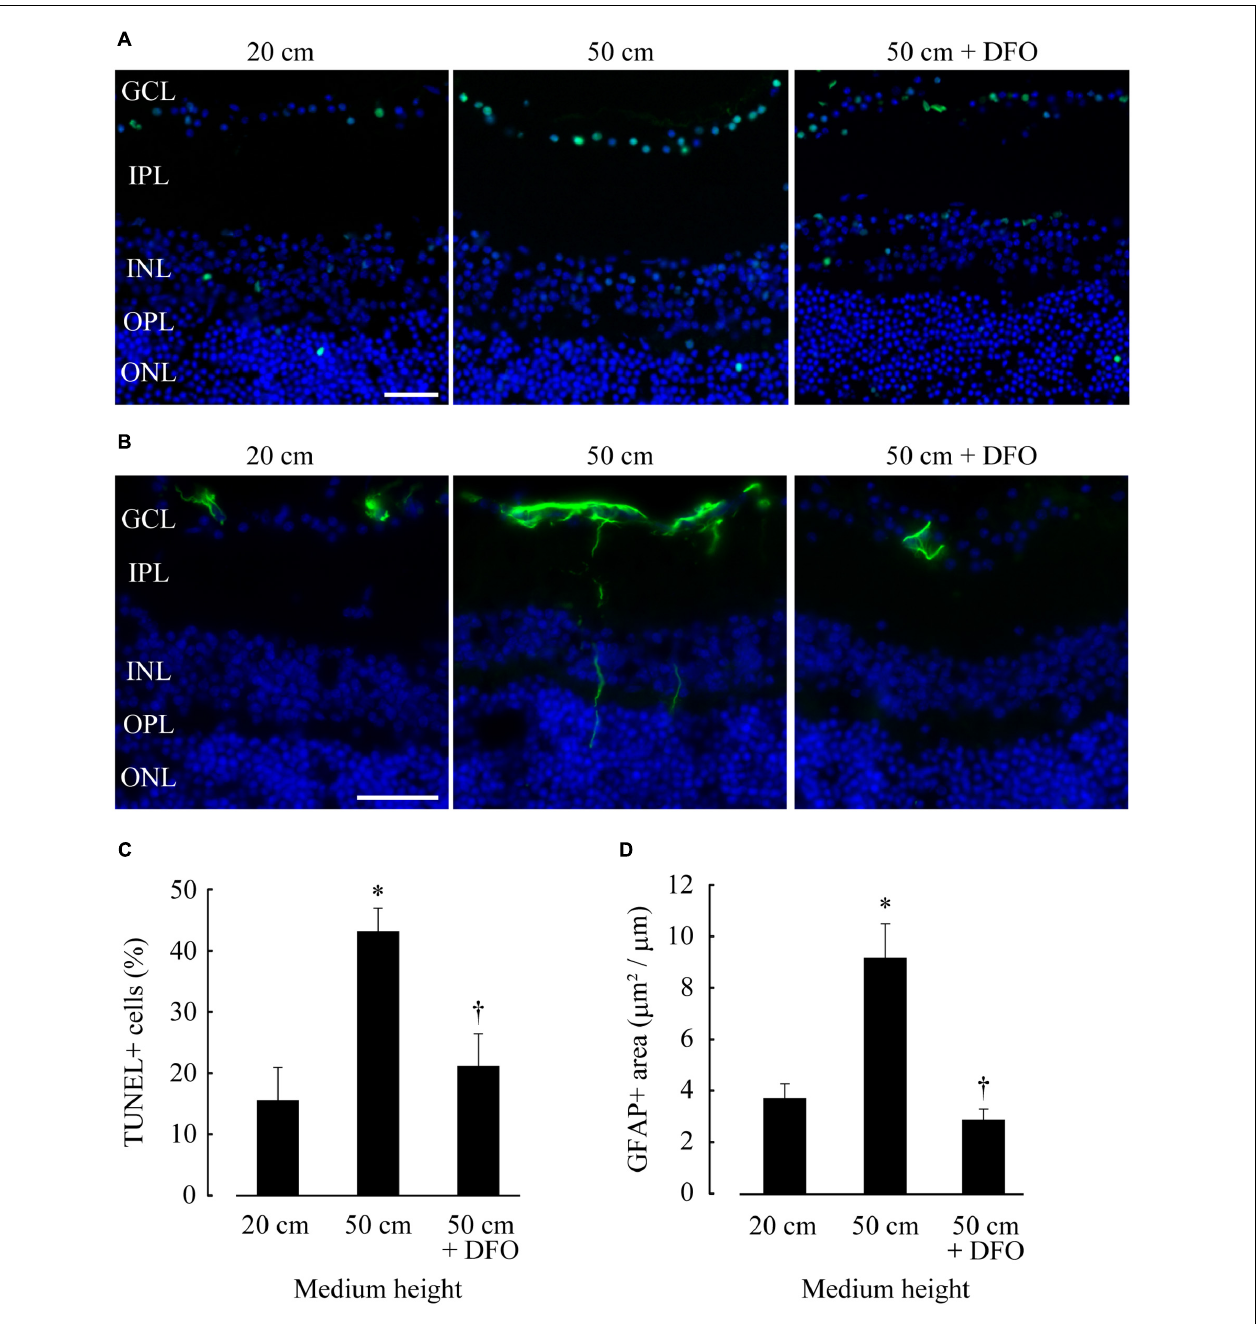
FIGURE 3 | Retinal ganglion cell (RGC) apoptosis and glial activation increased at 50 cm H 2 O pressure and decreased following deferoxamine (DFO) treatment. (A,B) In situ TUNEL (A, green) and GFAP immunohistochemistry [ (B) , green] assays were performed on frozen sections of retinae, and the sections were counterstained with DAPI [ (A,B) , blue]. Bar = 40 µ m. GCL, ganglion cell layer; IPL, inner plexiform layer; INL, inner nuclear layer; OPL, outer plexiform layer; ONL, outer nuclear layer. (C,D) The average percentage of TUNEL-positive nuclei in GCL (positive cell number/total cell number) and the average GFAP-positive area in retinae (positive area/horizontal length) are shown in (C,D) , respectively. * p ≤ 0.05 vs. 20 cm, † p ≤ 0.05 vs. 50 cm.